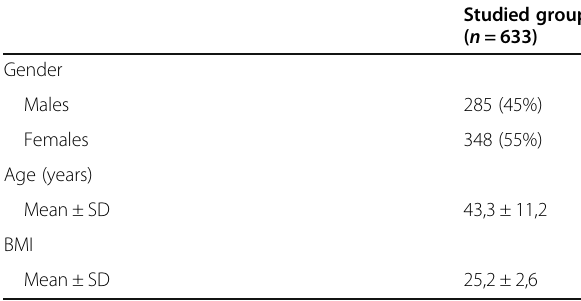
Table 1 Characteristics of the study